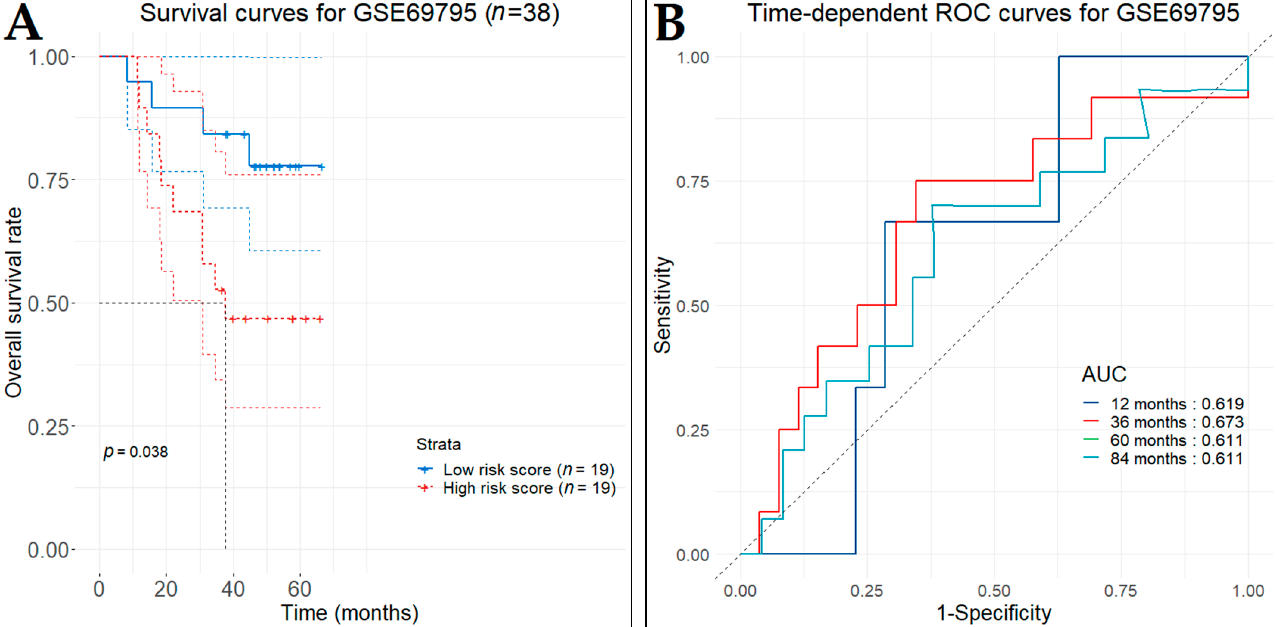
Figure 23. Survival analysis using the GSE69795 ( n = 38) dataset (second test set). ( A ) Kaplan–Meier curves for disease-free survival of MIBC patients who received cisplatin-based chemotherapy as stratified by the six-gene predictive index. Patients were divided into low- and high-risk groups according to the median predictive index. ( B ) Time-dependent ROC curves (one-, three-, five-, and seven-year predictions) to assess the predictive accuracy of the six-gene predictive model.